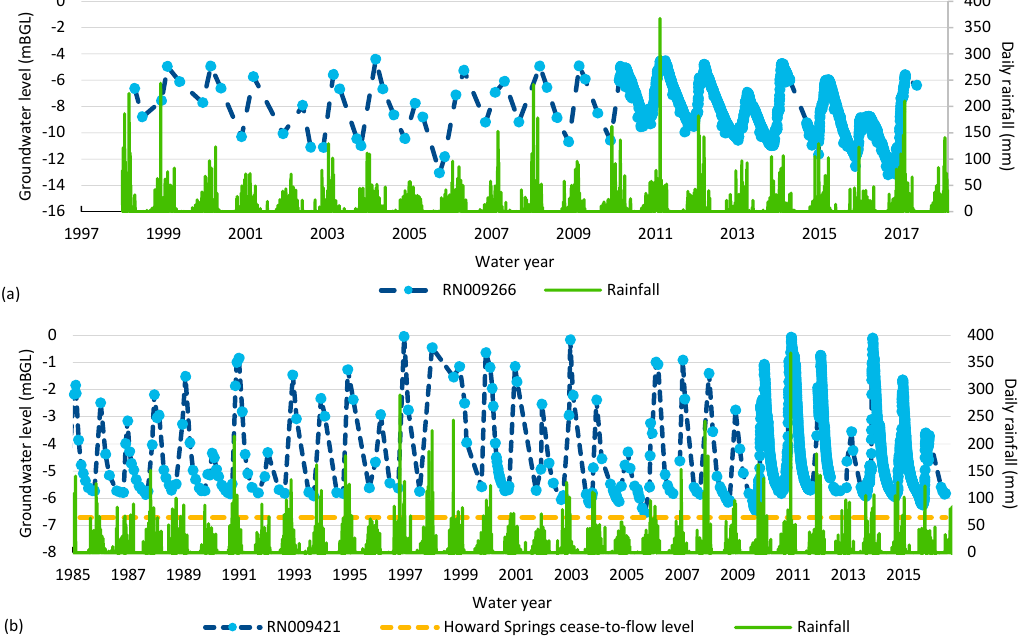
Figure1. HydrographsofboresintheDarwinruralarea: ( a )RN009266atMiddlePointand( b )RN009421 Figure 1. Hydrographs of bores in the Darwin rural area: ( a ) RN009266 at Middle Point and ( b ) at Howard RN009421 at Howard Springs.